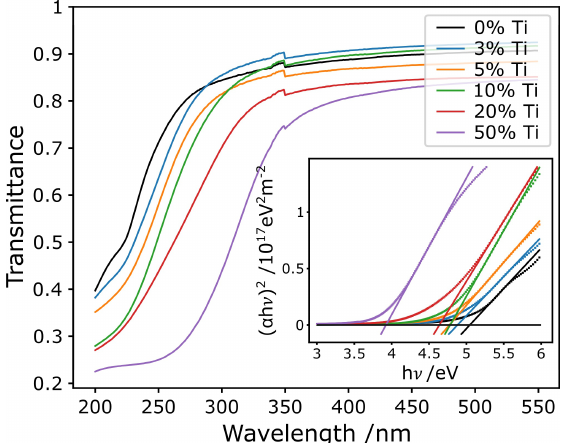
Figure 4. UV-vis transmittance spectra for the (Ti,Ga) 2 O 3 samples. The inset shows Tauc plots evaluated using the transmittance data for each film. The straight, solid lines are the fits to the linear region of the Tauc plots and their intercepts with the dotted black line ( α =0) gives the band gaps of the respective films.